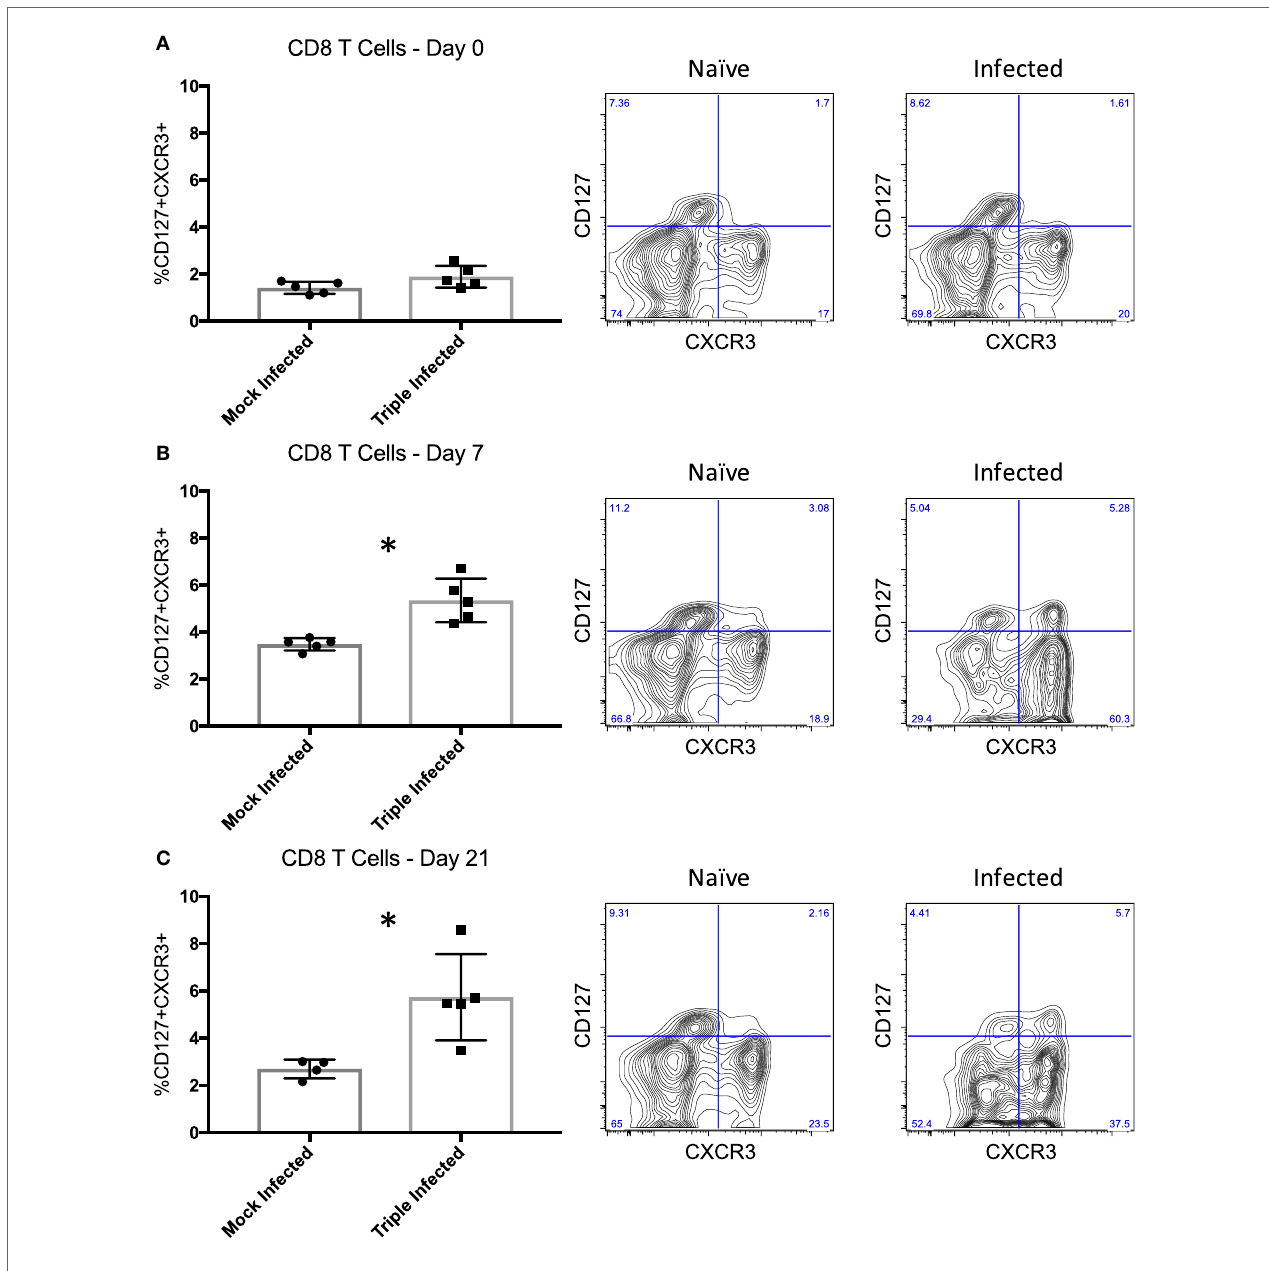
FigUre 4 | High quality memory cells emerge following infection with polyomavirus, murine cytomegalovirus, and HV68. (a) Prior to infection, mice do not have a distinct population of CD127 + CXCR3 + CD8 T cells indicative of quality memory ( n = 5 per group). (B) On day 7 post-infection, there is a significant increase in CD127 + CXCR3 + CD8 T cells ( p = 0.0025, calculated using unpaired t test). (c) The increase of CD127 + CXCR3 + cells is sustained through day 21 post-infection ( p = 0.0146, calculated using unpaired t test). Representative flow plots of peripheral blood mononuclear cells from naïve and infected mice are shown to the right of the summary data for each time